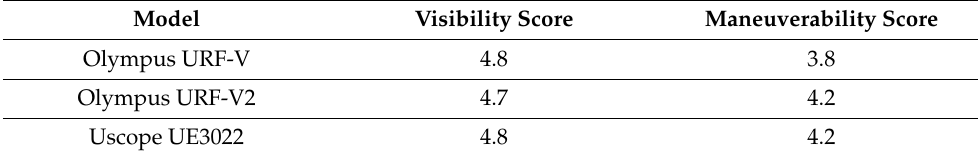
Table 2. Comparative visibility and maneuverability scores of the three